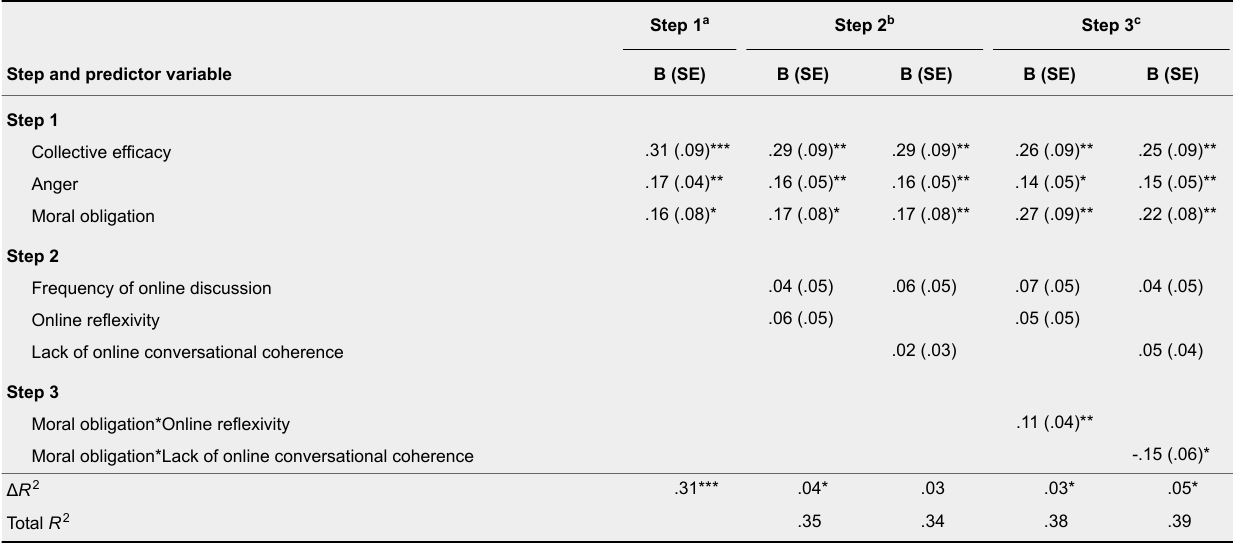
Hierarchical Regressions of Politicized Identity on Moral Obligation, Group-Based Motivations, Frequency of Online Discussion, Perceived Features of Online Discussion, and